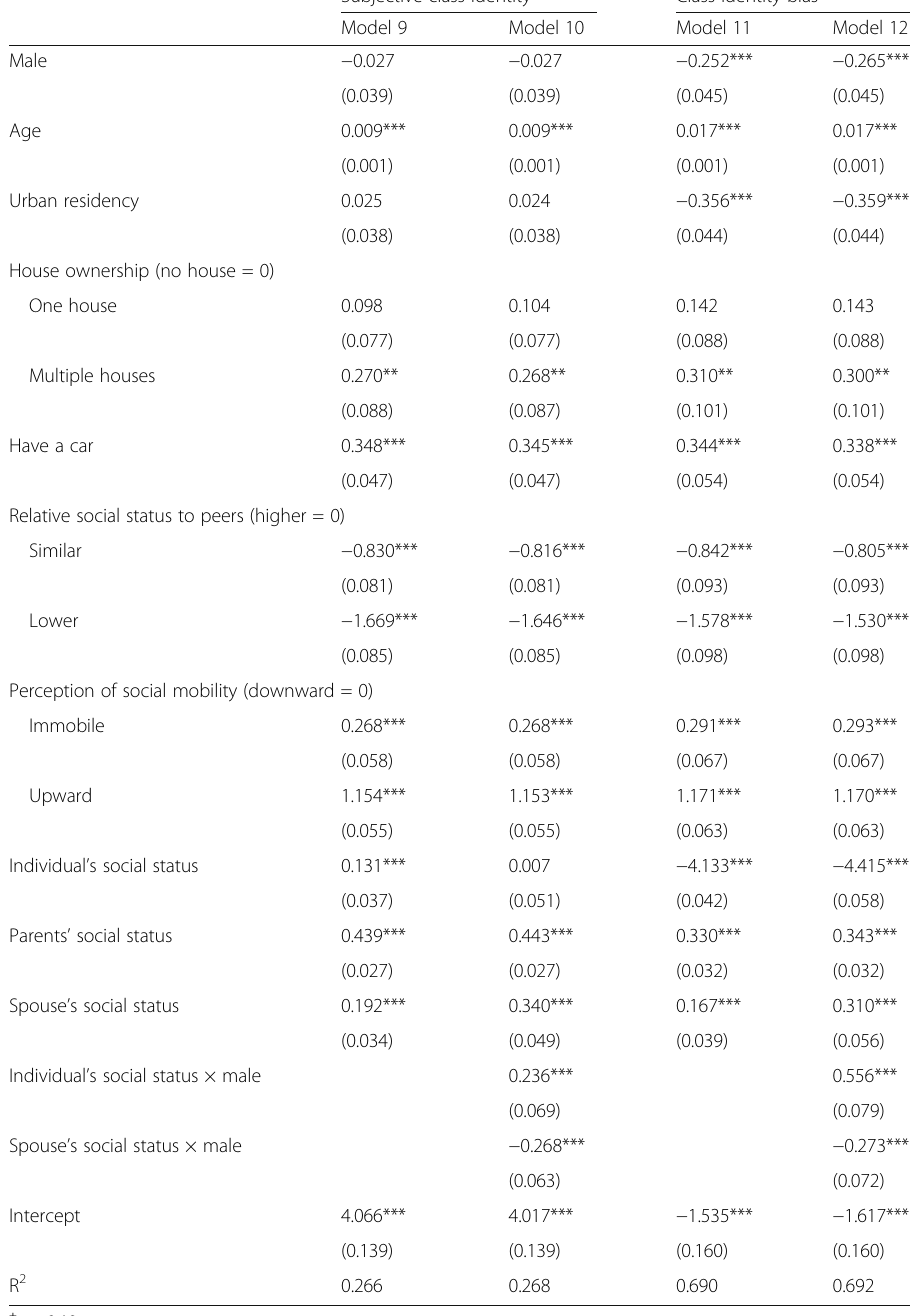
Table 5 The effect of spouse ’ s social status on individual class identity and bias ( N =